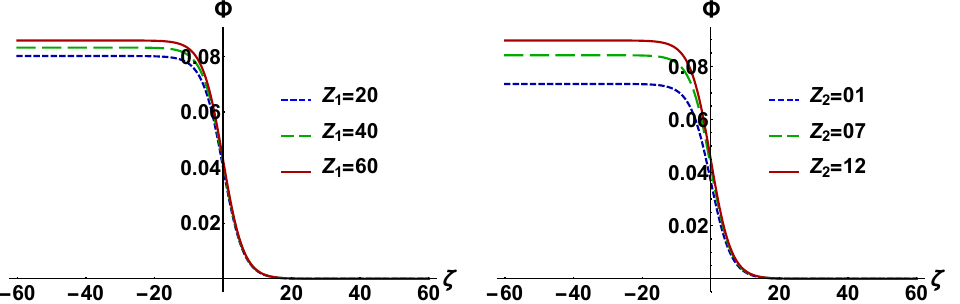
Figure 3. Plot of Φ vs. ζ for different values of Z 1 ( left panel ) and for different values of Z 2 ( right panel ) when α = 5/3, δ = 20 ◦ , η = 0.3, γ e = 4/3, Z 1 = 37, Z 2 = 6, n 10 = 10 29 cm − 3 , = 10 33 cm − 3 , U = 0.05, and v p = v p + n 20 = 10 30 cm − 3 , n e 0 0